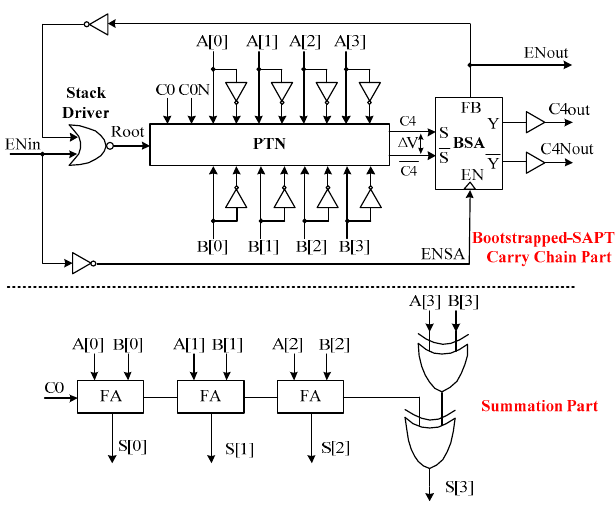
Figure 3. The 4 bit bootstrapped sense amplifier-based pass transistor logic (SAPTL) adder block.